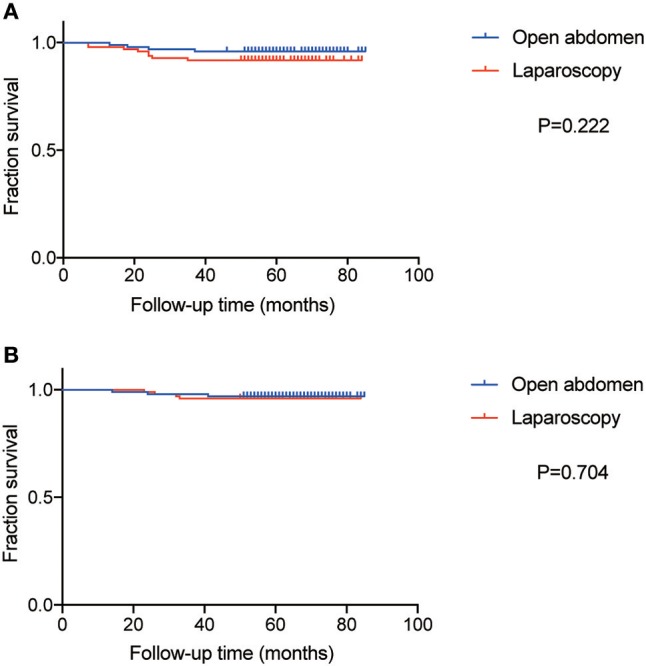
The curve of Disease-free survival (DFS) and overall survival (OS). (A) The curve of DFS. (B) The curve of OS.